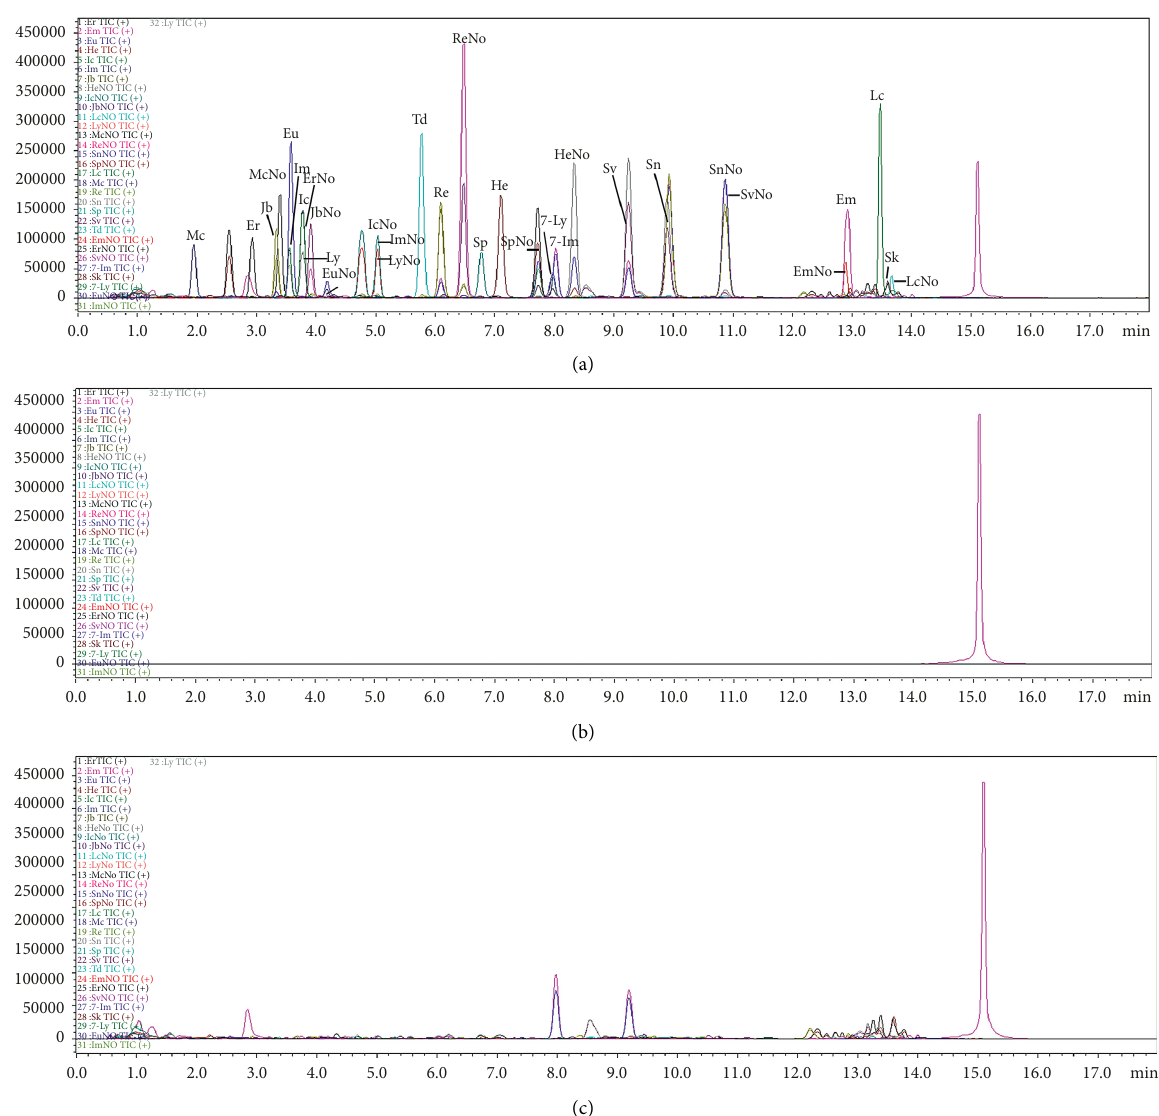
Figure 2: UPLC-MS/MS chromatogram of XYT: (a) 50ppb standard solution (mixed with XYT blank solution), (b) XYT blank solvent, and (c) XYT blank solution. For the abbreviations of the compounds, see 2.1